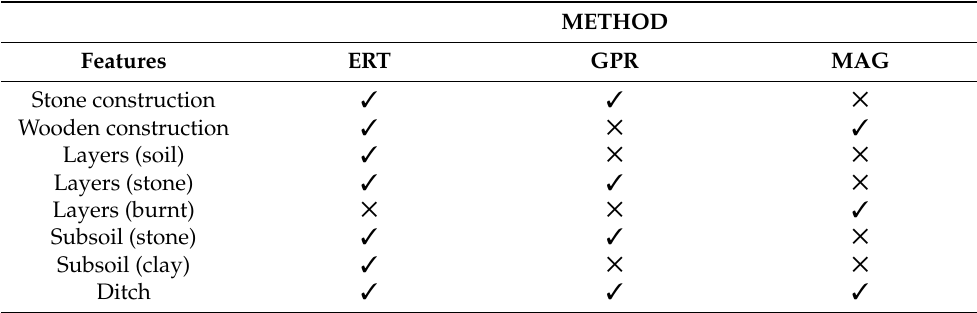
Table 2. Comparison of magnetometry, GPR, and ERT methods concerning identifying individual features within the surveyed ramparts: (cid:51) —identified; (cid:53) —not